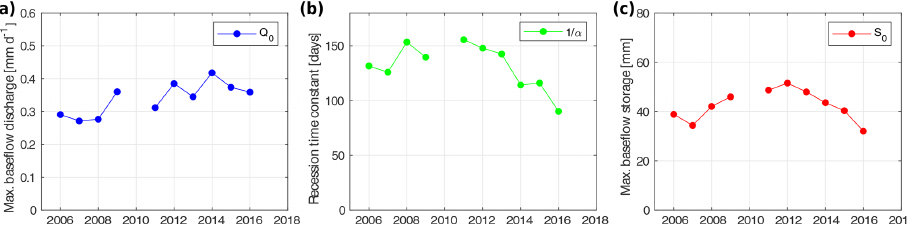
Figure 11. Temporal evolution of the recession characteristics obtained from the annual recession analysis of the Otemma catchment, showing the results of the best-fitted parameters for (a) maximum baseflow ( Q 0 ), (b) recession constant (1 /α ), and (c) maximum baseflow storage ( S 0